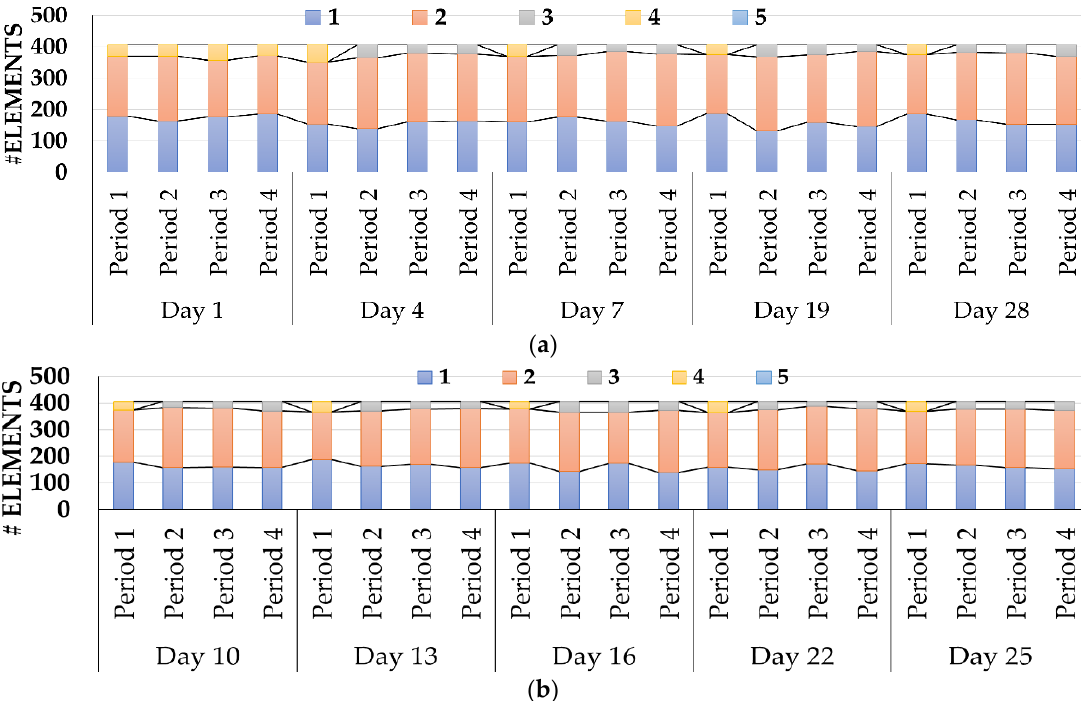
Figure 6. Number of elements per Reliability Rate group considering the initial rate being: ( a ) DR event 1; ( b ) DR event 2.